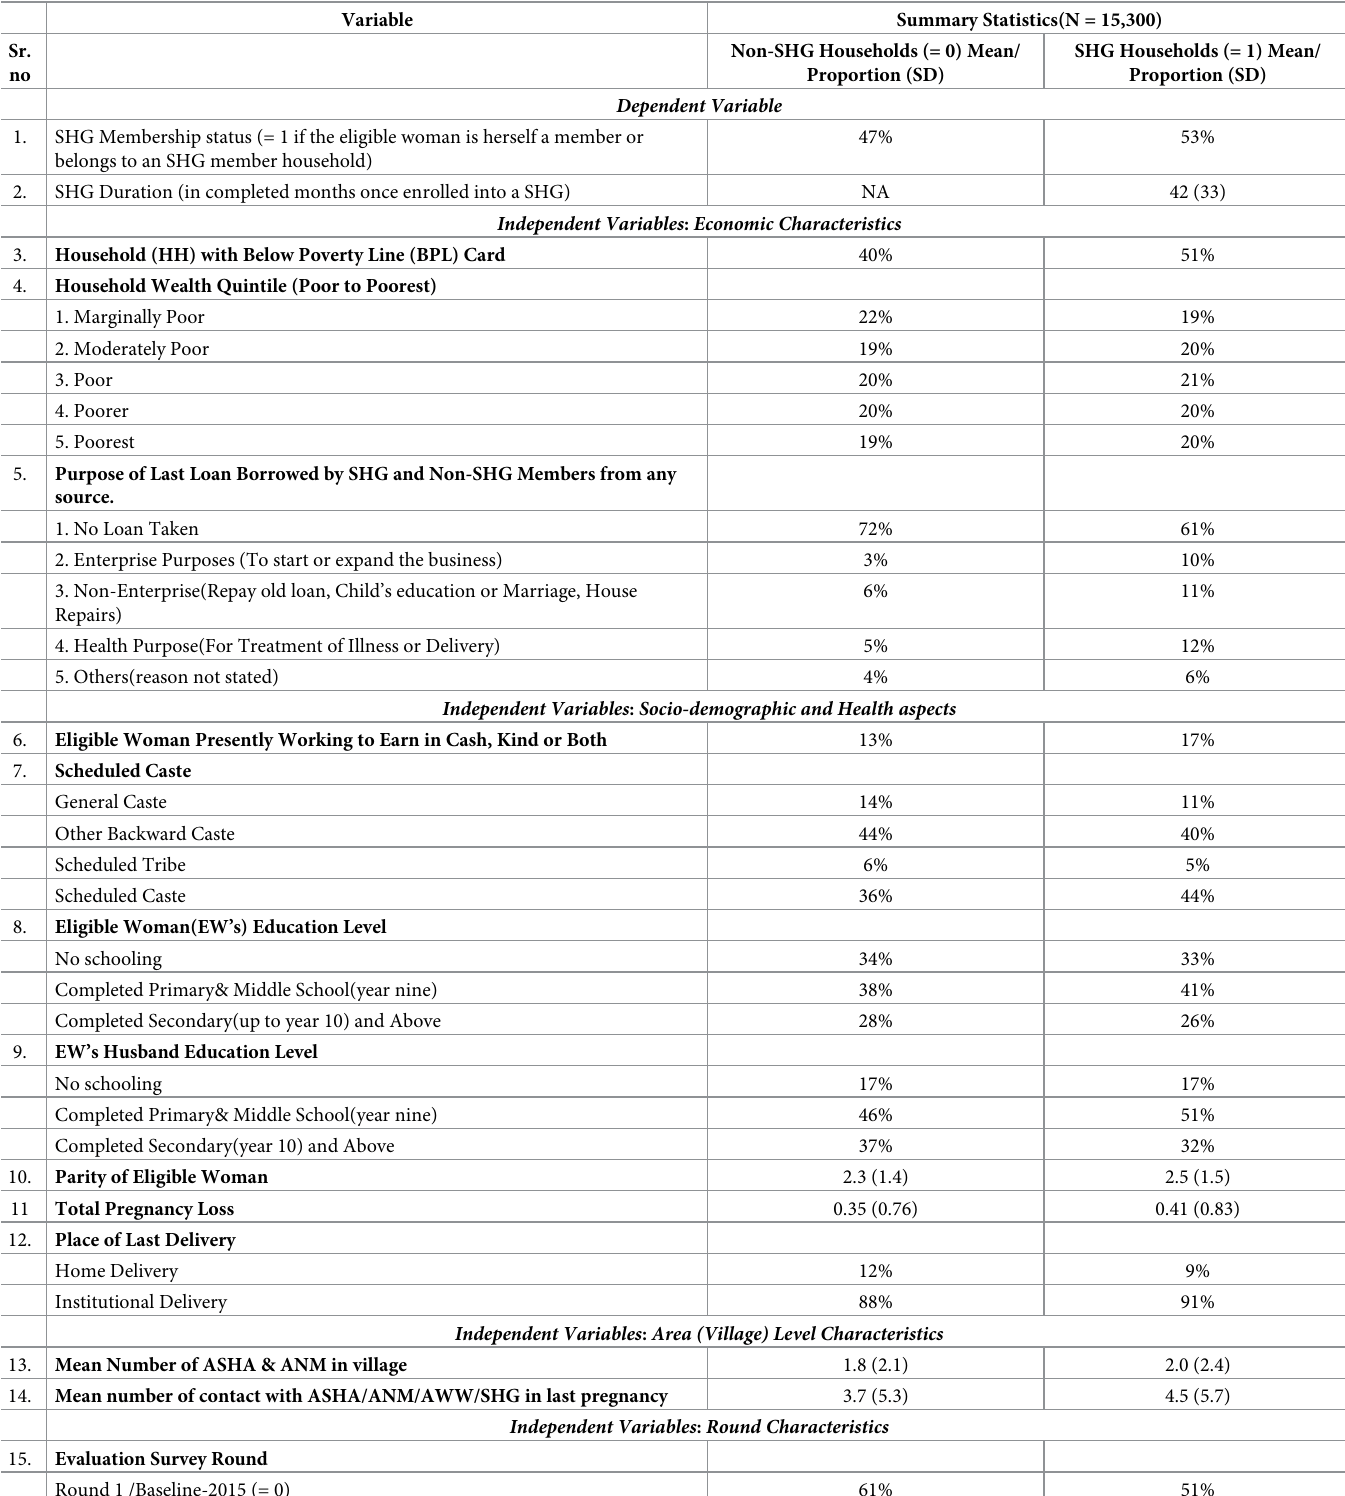
Table 1. Summary statistics of selected variables by Non-Self-Help Group [Non-SHG] Household and Self-Help Group [SHG]